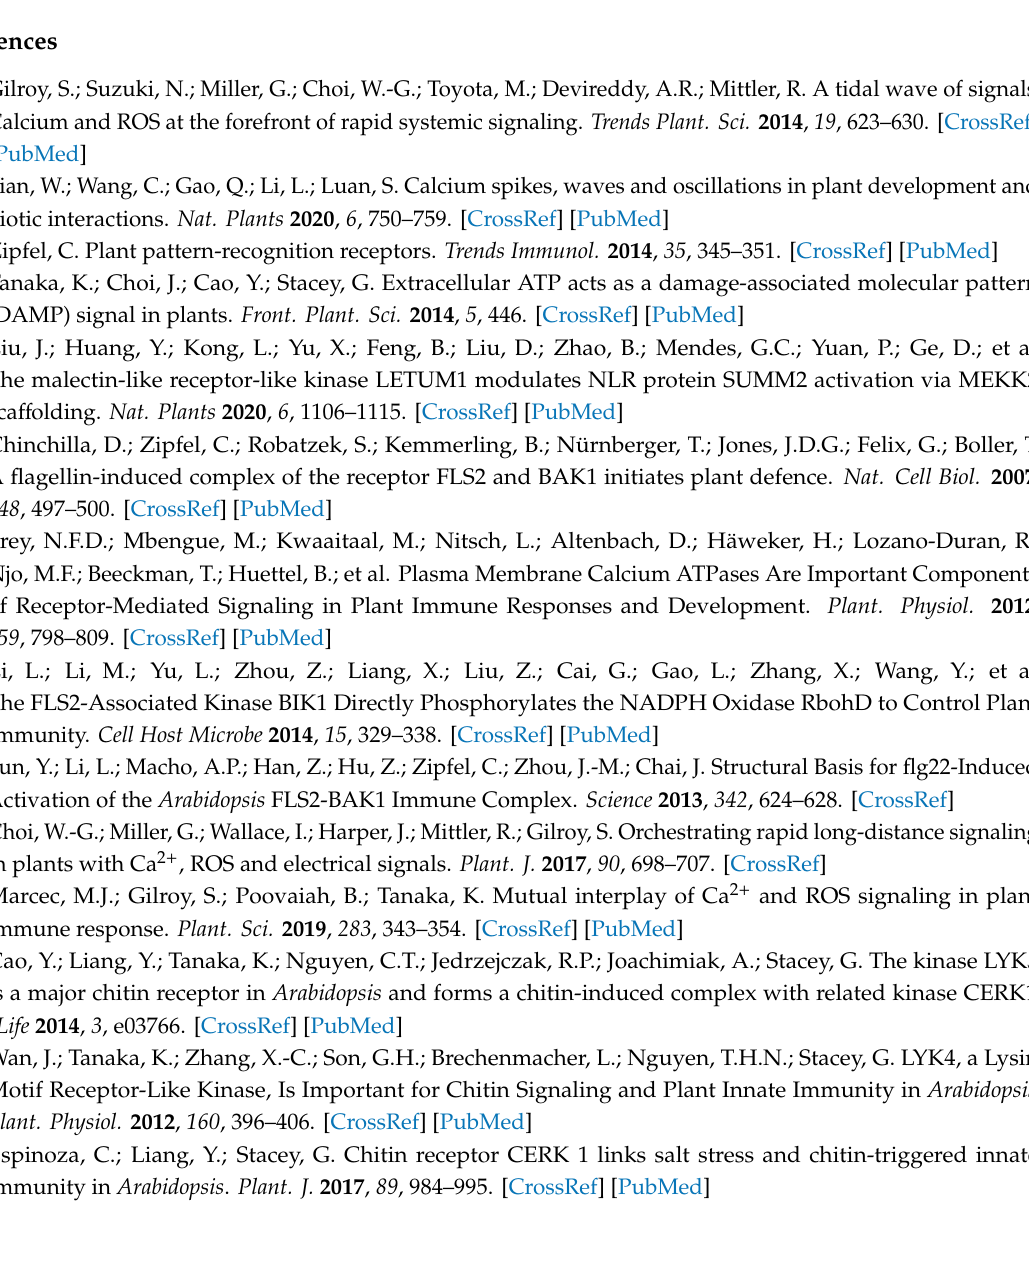
Table S1: List of primers for qRT-PCR for SA or JA related